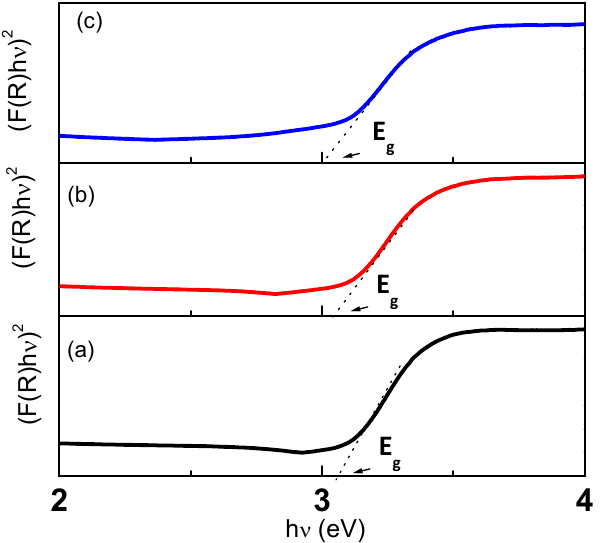
Figure 12. Tauc plots of the BaTiO 3 ceramics sintered at ( a ) 1100 °C, ( b ) 1200 °C, and ( c ) 1300 °C.